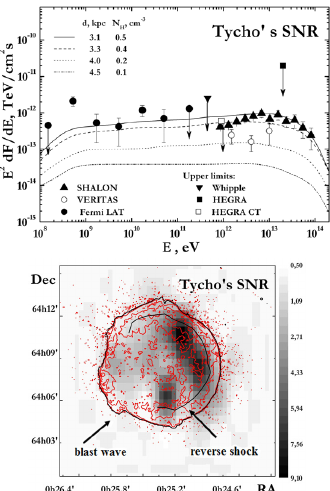
Figure 2. Characteristics of Tycho’s SNR: top: Spectral energy distributions of high- and very high energy γ -ray emission by SHALON ( (cid:31) ) in comparison with other experiments. Lines show the gamma-ray spectra calculated for four distances d and the corresponding densities of the interstellar medium N H . bottom: Image of SNR in the energy range 0 . 8 80 TeV by SHALON − (grey scale). Red contours are the X-ray emission by Chandra. Contour levels are 0.8% 2.2%, 6.2%, 18% and 51% of the X-ray emission map maximum.